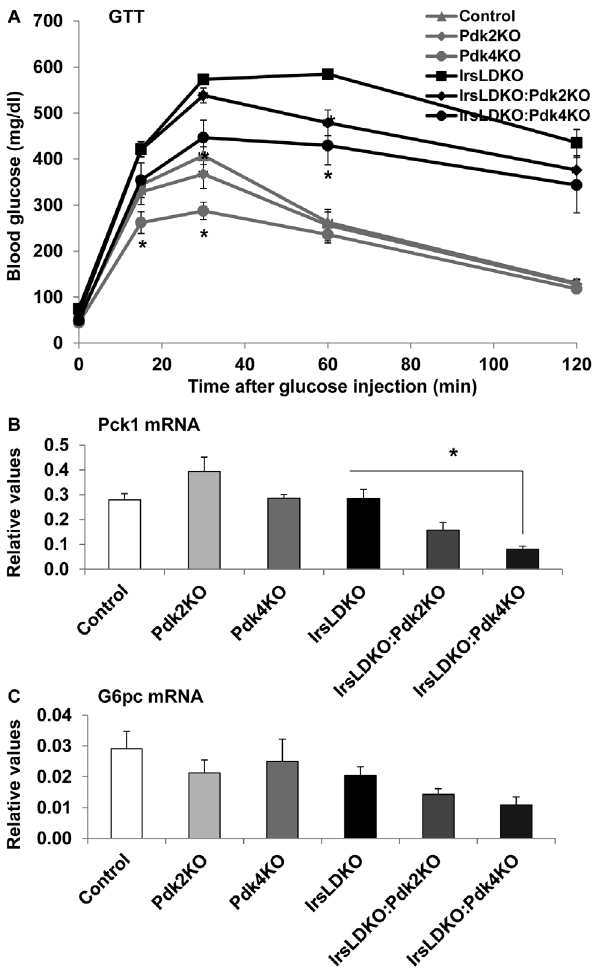
Figure 3. Ablation of Pdks improves glucose tolerance in IrsLDKO mice. A, Glucose tolerance tests (GTT) were performed in age-matched control and knockout mice (n=8–12). B and C, Expression of gluconeogenic genes Pck1 and G6pc was analyzed in the liver of overnight fasted control and knockout mice (n=3). Data are presented as means 6 SEM. *, P , 0.05 relative to corresponding